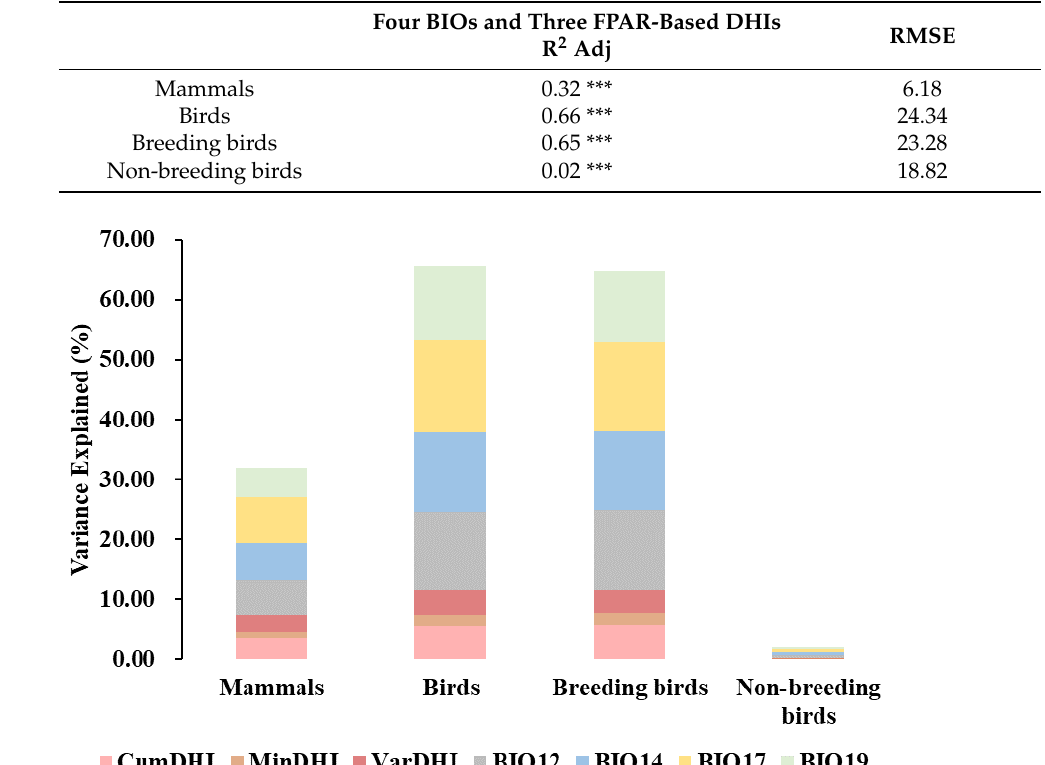
Table 5. Coefficient of determination between the four Bioclim variables (BIO12, BIO14, BIO17 and BIO19), as well as the FPAR-based DHIs to the three significant relations: *** p < 0.001.